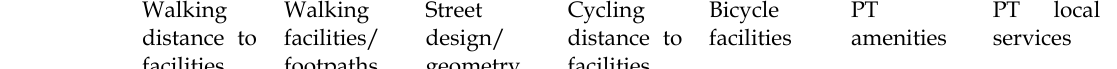
Correlations between local access constructs (Pearson correlation and